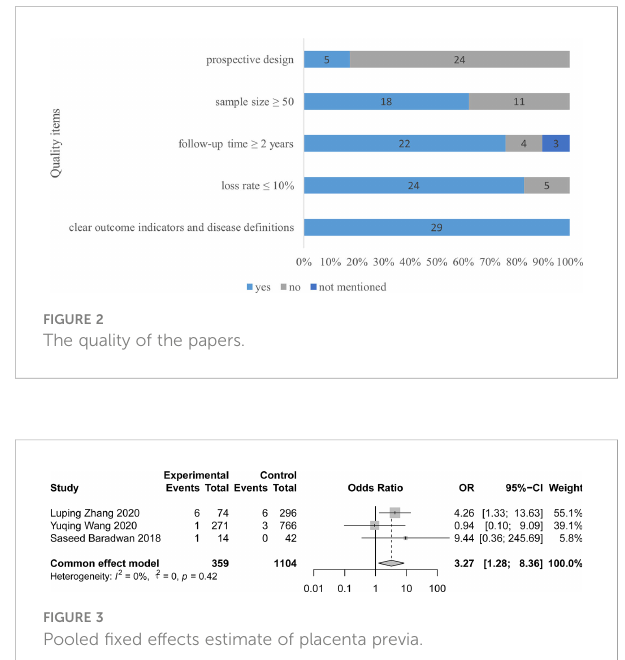
FIGURE 3 Pooled fi xed effects estimate of placenta